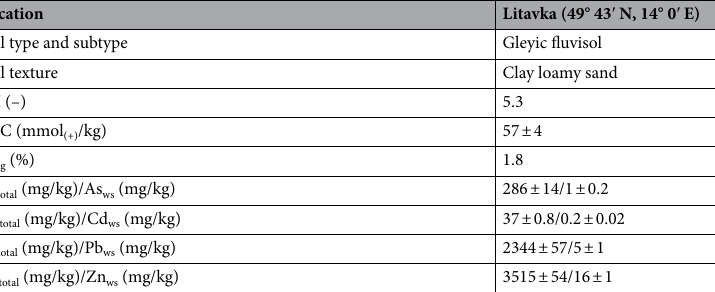
Table 1. Characteristics of the contaminated soil used for soil dust application. CEC is the cation exchange capacity, C org is organic carbon, (As, Cd, Pb or Zn) total is the pseudototal content of elements determined by ICP–MS (extraction by aqua regia), and (As, Cd, Pb or Zn) ws is the water-soluble content of elements determined by ICP–OES (24-h extraction by demineralized water, 1:5 w/v). Czech legislation limits for pseudototal contents of elements in light-textured soils (mg/kg): As—15, Cd—0.4, Pb—55 and Zn—105 30